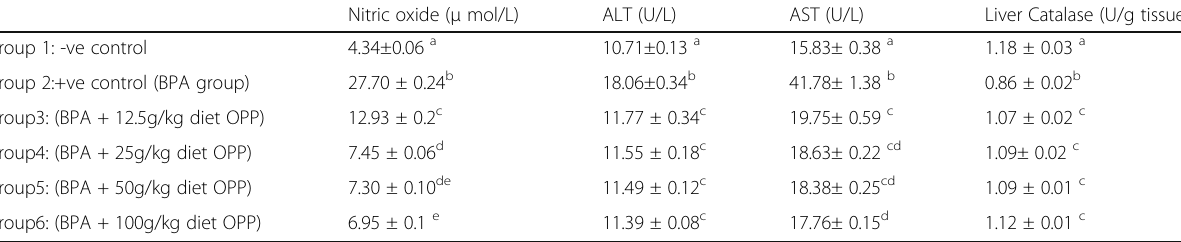
Table 2 The effect of orange peel powder on serum nitric oxide level, ALT, AST, and liver catalase activities in BPA-treated rats